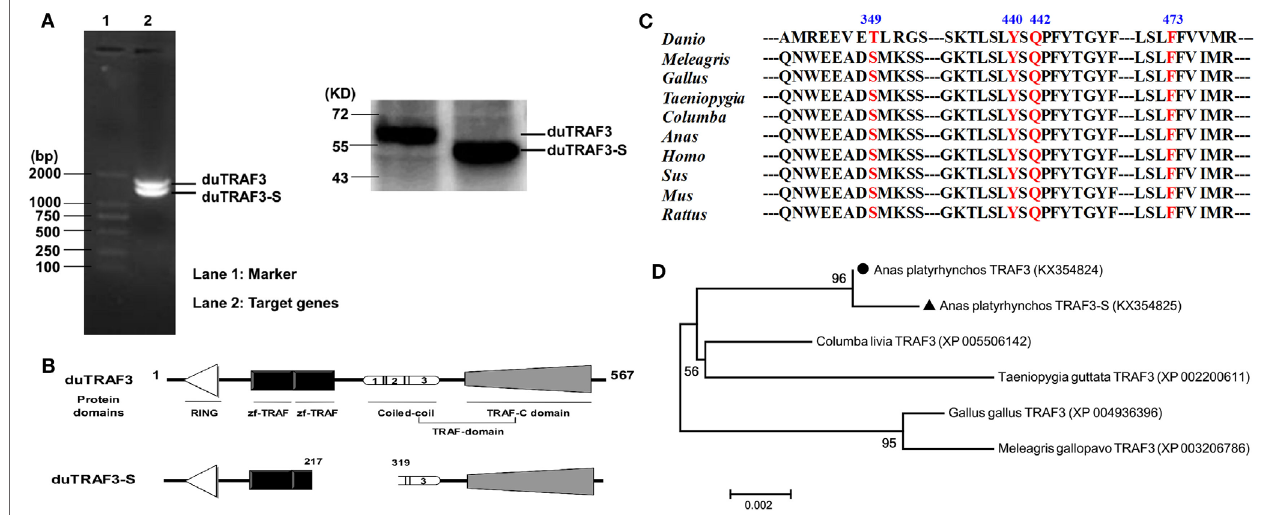
FigUre 1 | Identification of a splice variant of duck TRAF3 (duTRAF3). (a) RT-PCR with duTRAF3-specific primers on RNA isolated from duck embryo fibroblasts and the western blot was used to detect the expression of constructed plasmids in 293T cells. (B) Schematic representation of duTRAF3 and spliced isoform of duTRAF3 (duTRAF3-S) protein structure, showing the four different domains. Three distinct coil regions numbered 1 (267-295), 2 (297-339), and 3 (345-367). (c) A cross-species sequence alignments of TRAF3 revealed the high conservation of important fragments. (D) Phylogenetic analysis of avian TRAF3. The tree was constructed by the neighbor-joining method using amino acid sequences aligned with MEGA 6. The scale bar indicated a branch length of